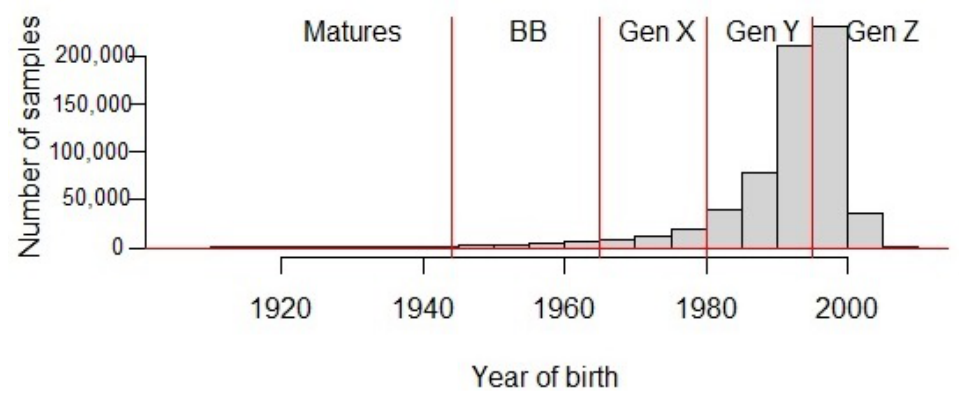
Figure 9. Sample distribution across different birth years. The vertical lines separate the age cohort represented in Table